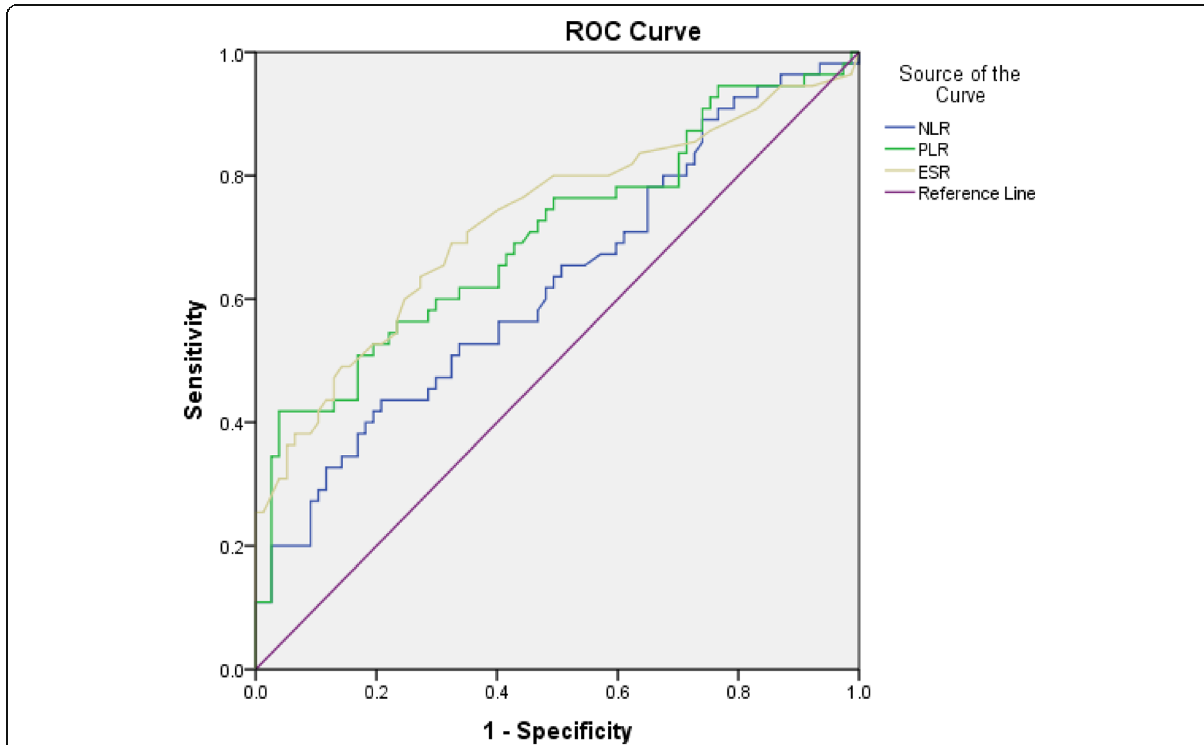
Fig. 5 ROC curve of NLR, PLR and ESR differentiating active AS from inactive AS